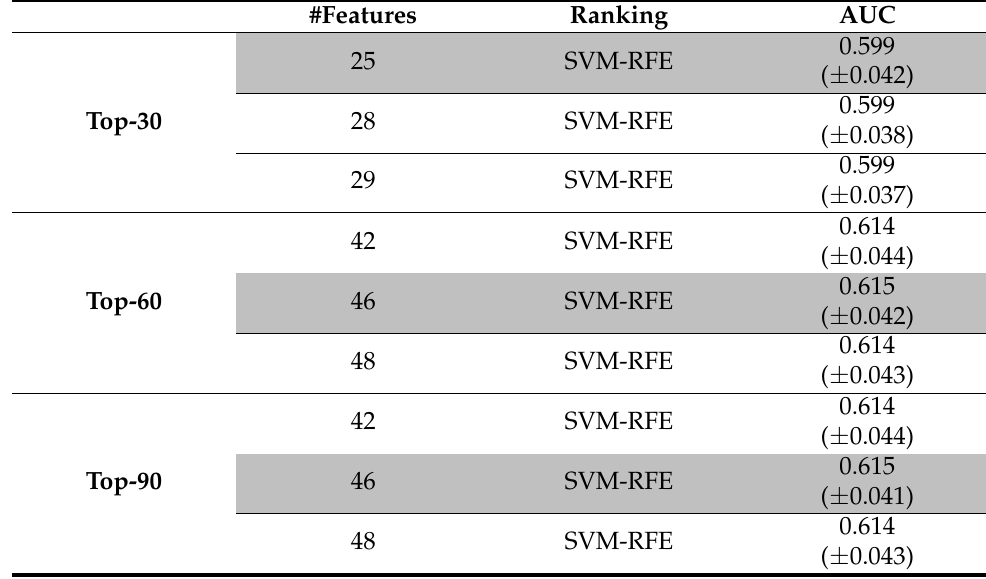
Table 6. Multi-Layer Perceptron classifier. In gray background the number of features with the best result.